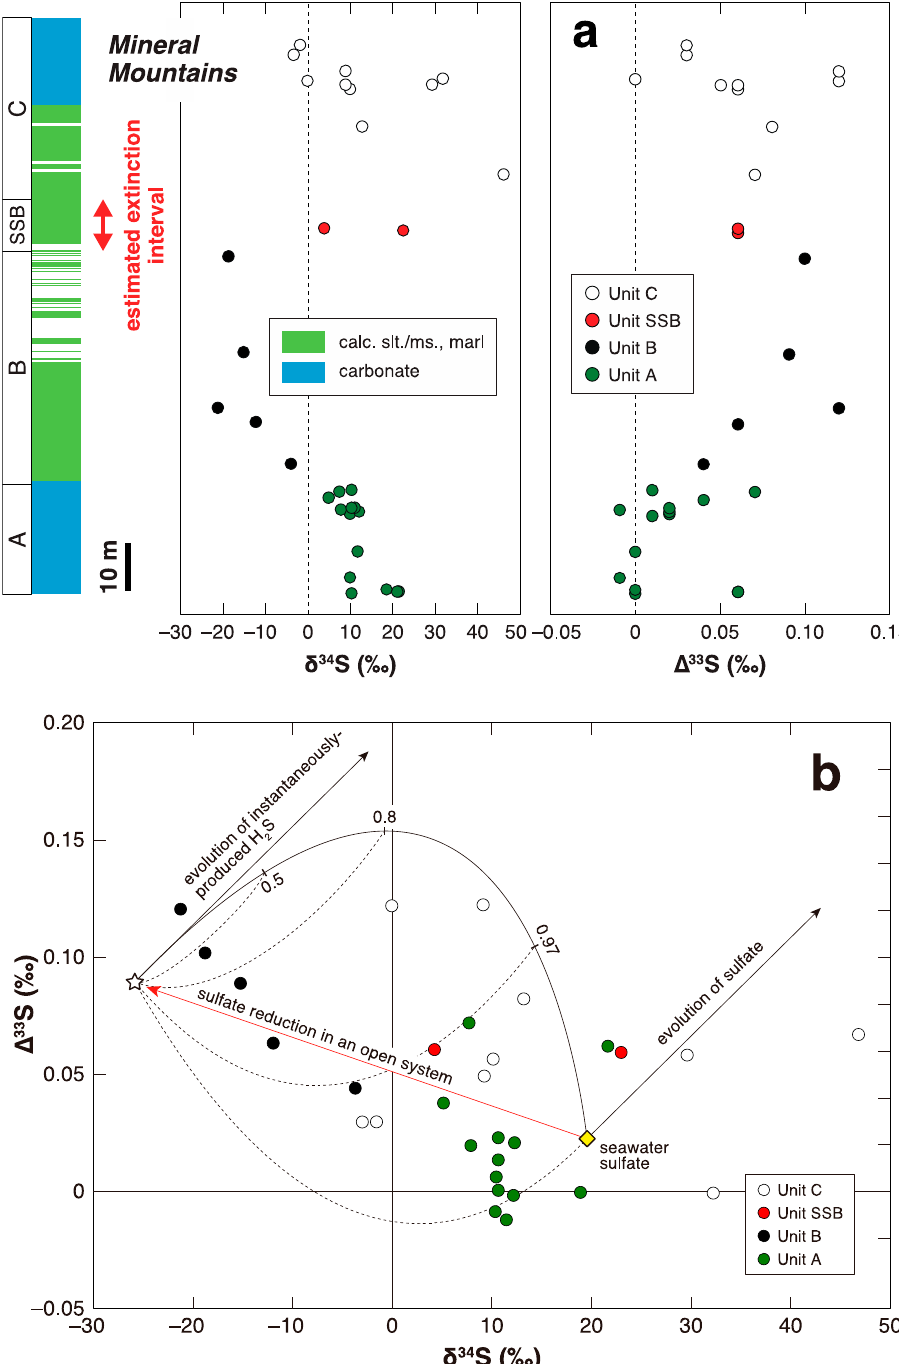
Figure 12. Multiple sulfur isotope record across the S-SB at Mineral Mountains [125]. ( a ) sulfur isotope chemostratigraphy. The estimated extinction interval is based on regional litho- and bio-stratigraphic correlations [126,127]. Alphabet along the log is unit name. calc.: calcareous, slt.: siltstone, ms.: mudstone; ( b ) δ 34 S– ∆ 33 S cross plot. Solid black arrows represent the evolution of the instantaneously produced H 2 S and the remaining sulfate via reduction of the contemporaneous seawater sulfate [68] in a closed system, assuming that the 34 ε and 33 λ values in MSR were 44.8‰ and 0.512 (red arrow), respectively. A solid black curve represents the evolution of accumulatively produced H 2 S. A number on the curve is a fraction of sulfate converted to H 2 S. A black dashed curve shows a mixing of accumulative H 2 S and sulfide produced in an open system (star). Note that the δ 34 S values increased from negative in the unit B to positive in the overlying units SSB and C, while the ∆ 33 S values remained consistently positive. It suggests that the sediments shifted from an open system (unit B) to a close system (units SSB and C) by the shutdown of bioturbation during the late-Smithian extinction